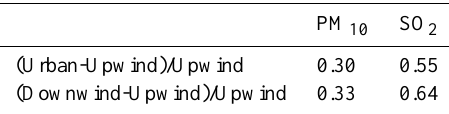
Table 1. Correlation coefficients between percent change of CG flashes and PM 10 and SO2